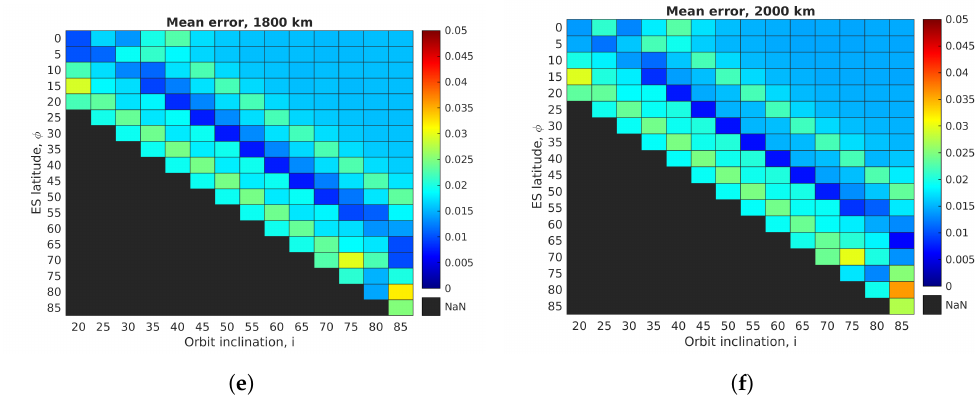
Figure A1. Mean error obtained with the proposed methodology, as compared with the simulation results for all the simulated orbit inclinations, i SAT , ES’s latitudes, φ ES , and altitudes, h k . ( a ) Proposed methodology vs simulations results at 1000 km; ( b ) Proposed methodology vs simulations results at 1200 km; ( c ) Proposed methodology vs simulations results at 1400 km; ( d ) Proposed methodology vs simulations results at 1600 km; ( e ) Proposed methodology vs simulations results at 1800 km; ( f ) Proposed methodology vs simulations results at 2000 km.